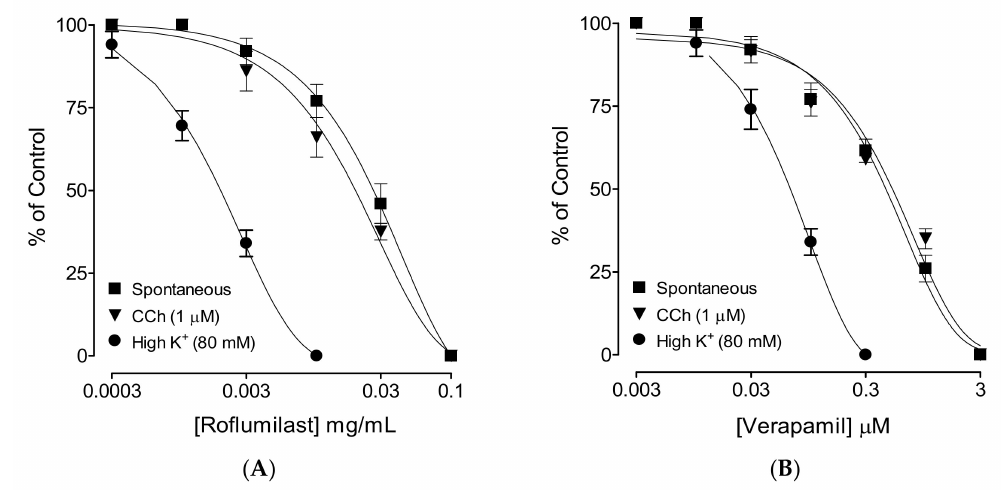
Figure 1. Concentration–response curves showing comparison of ( A ) roflumilast and ( B ) verapamil for their inhibitory e ff ect against spontaneous, carbachol (CCh, 1 µ M)- and high K + (80 mM)-induced contractions in isolated rabbit jejunum preparations. Values shown are mean ± SEM, n = 4–5.